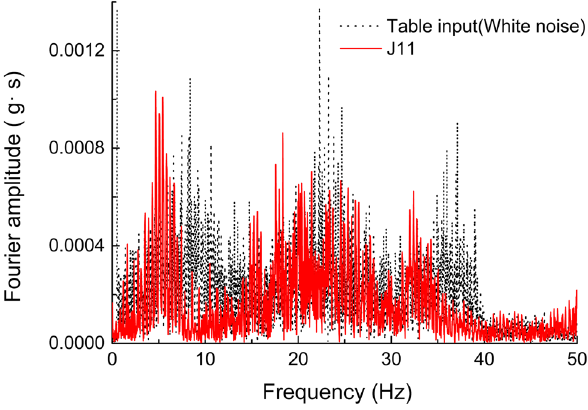
Figure 6: Typical example of Fourier spectrum in white noise tests.